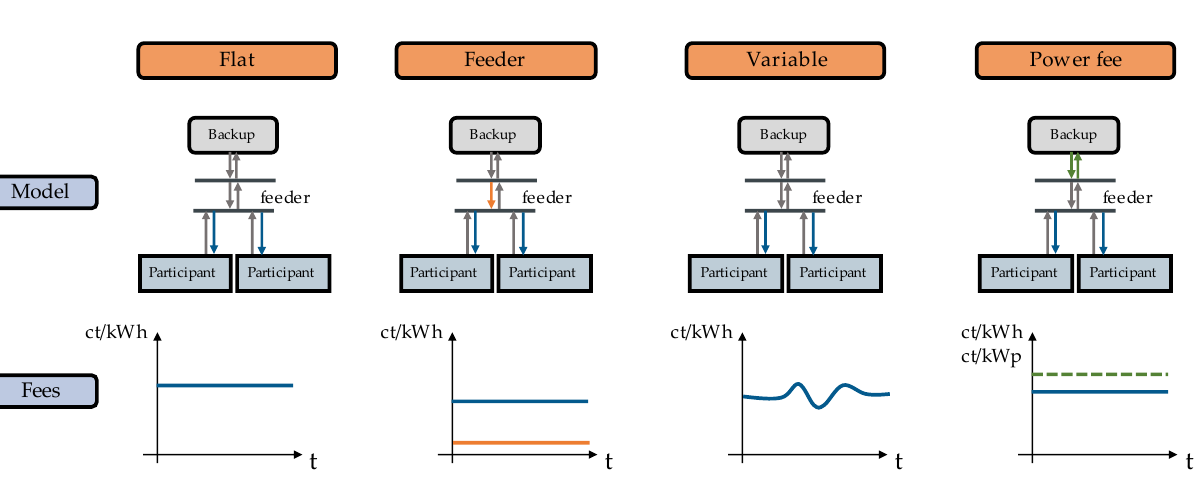
Figure 3. Overview of analyzed grid tariff models for LEMs. Lines and arrows: blue — participant